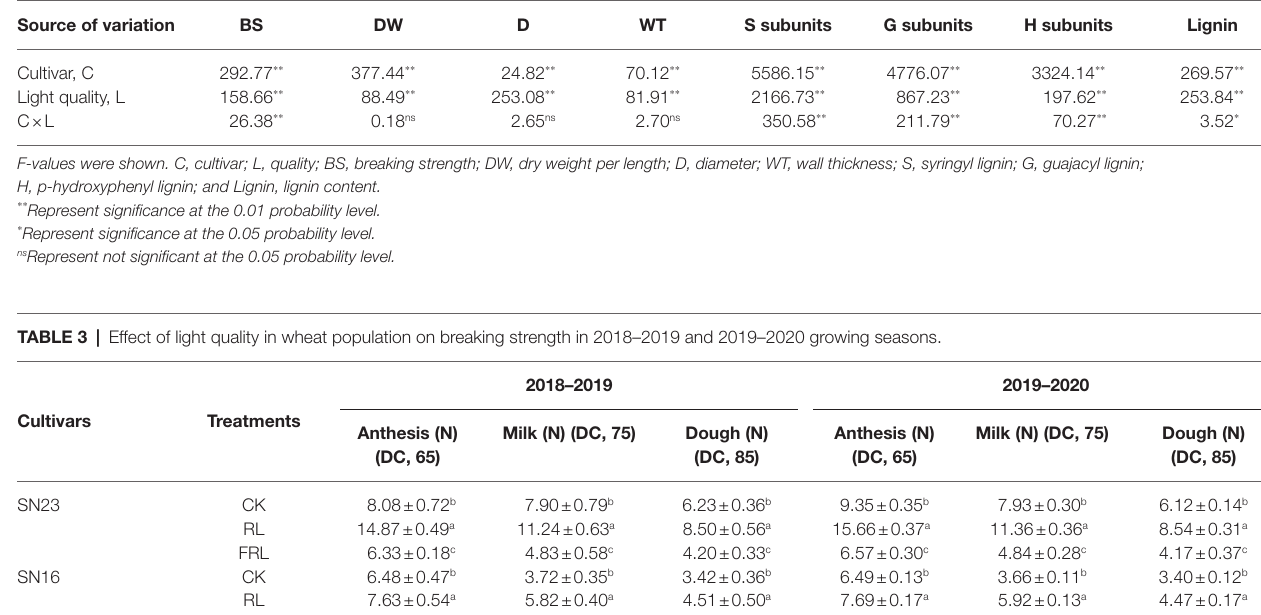
TABLE 2 | Variance analyses for the effects of the cultivar (C) and light quality (L) on breaking strength, the content of S, G, and H subunits, and lignin content of stems as well as dry weight per length, diameter, and wall thickness, in two wheat cultivars. Source of variation BS DW D WT S subunits G subunits H subunits Cultivar, C